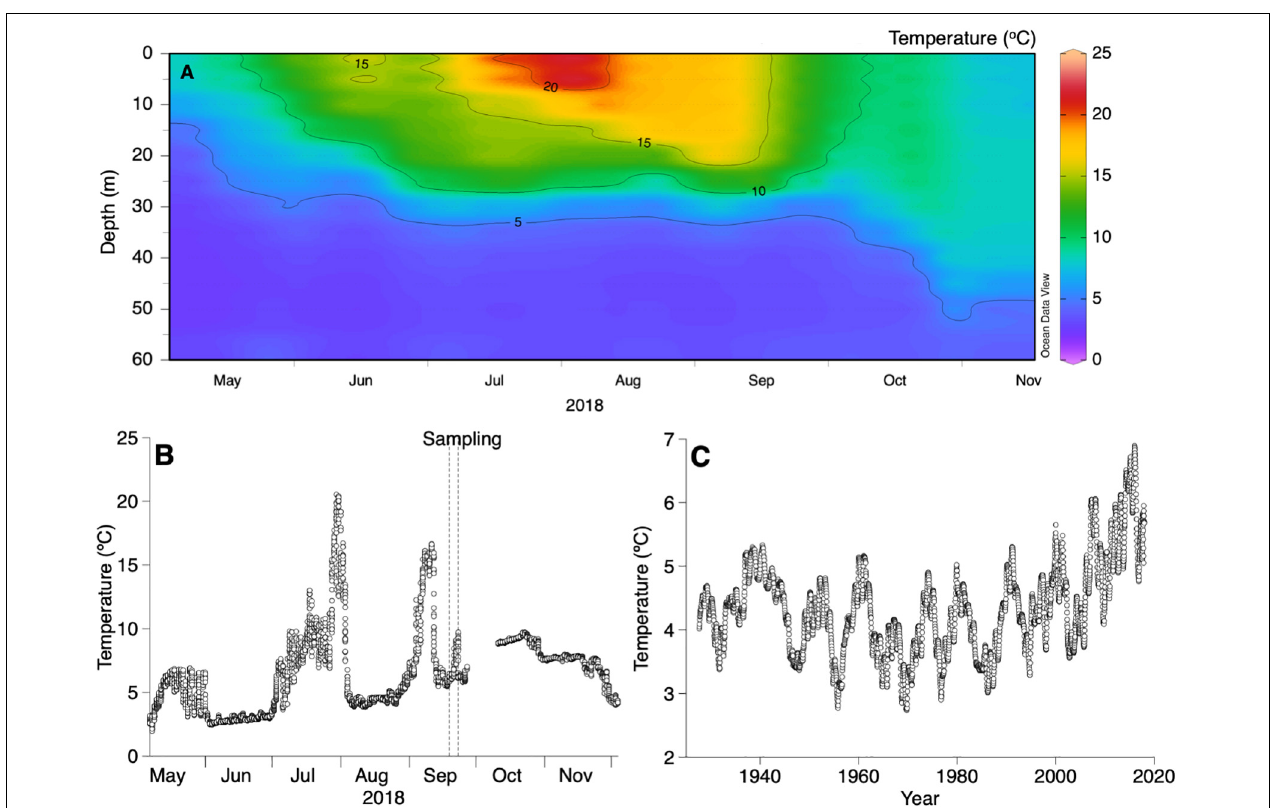
FIGURE 3 | Temperature records from (A) open Baltic Sea (vertical water column profile) during the heat wave in 2018 (May–November; Huvudskär, lat: 58.9333, lon: 19.1667; 100 m water depth; daily average), (B) bottom waters (31 m water depth) at the TZS coastal monitoring site during the heat wave in 2018 (May–November; Storfjärden, lat: 59.85548, lon: 23.26033; hourly measurements) and (C) bottom waters (31 m water depth) at the TZS coastal monitoring site (long-term temperature data 1926–2018; 1-year moving average).